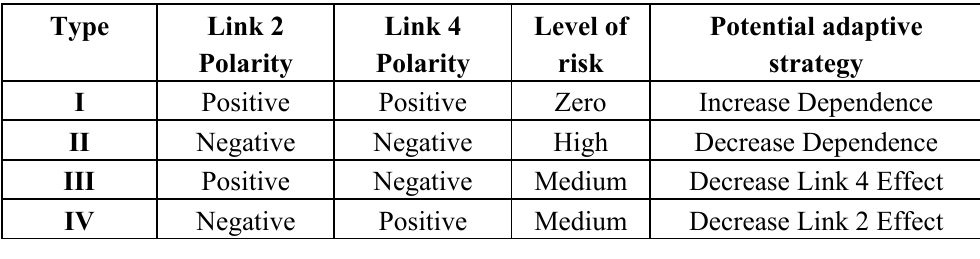
Table 4. Classification of adaptation